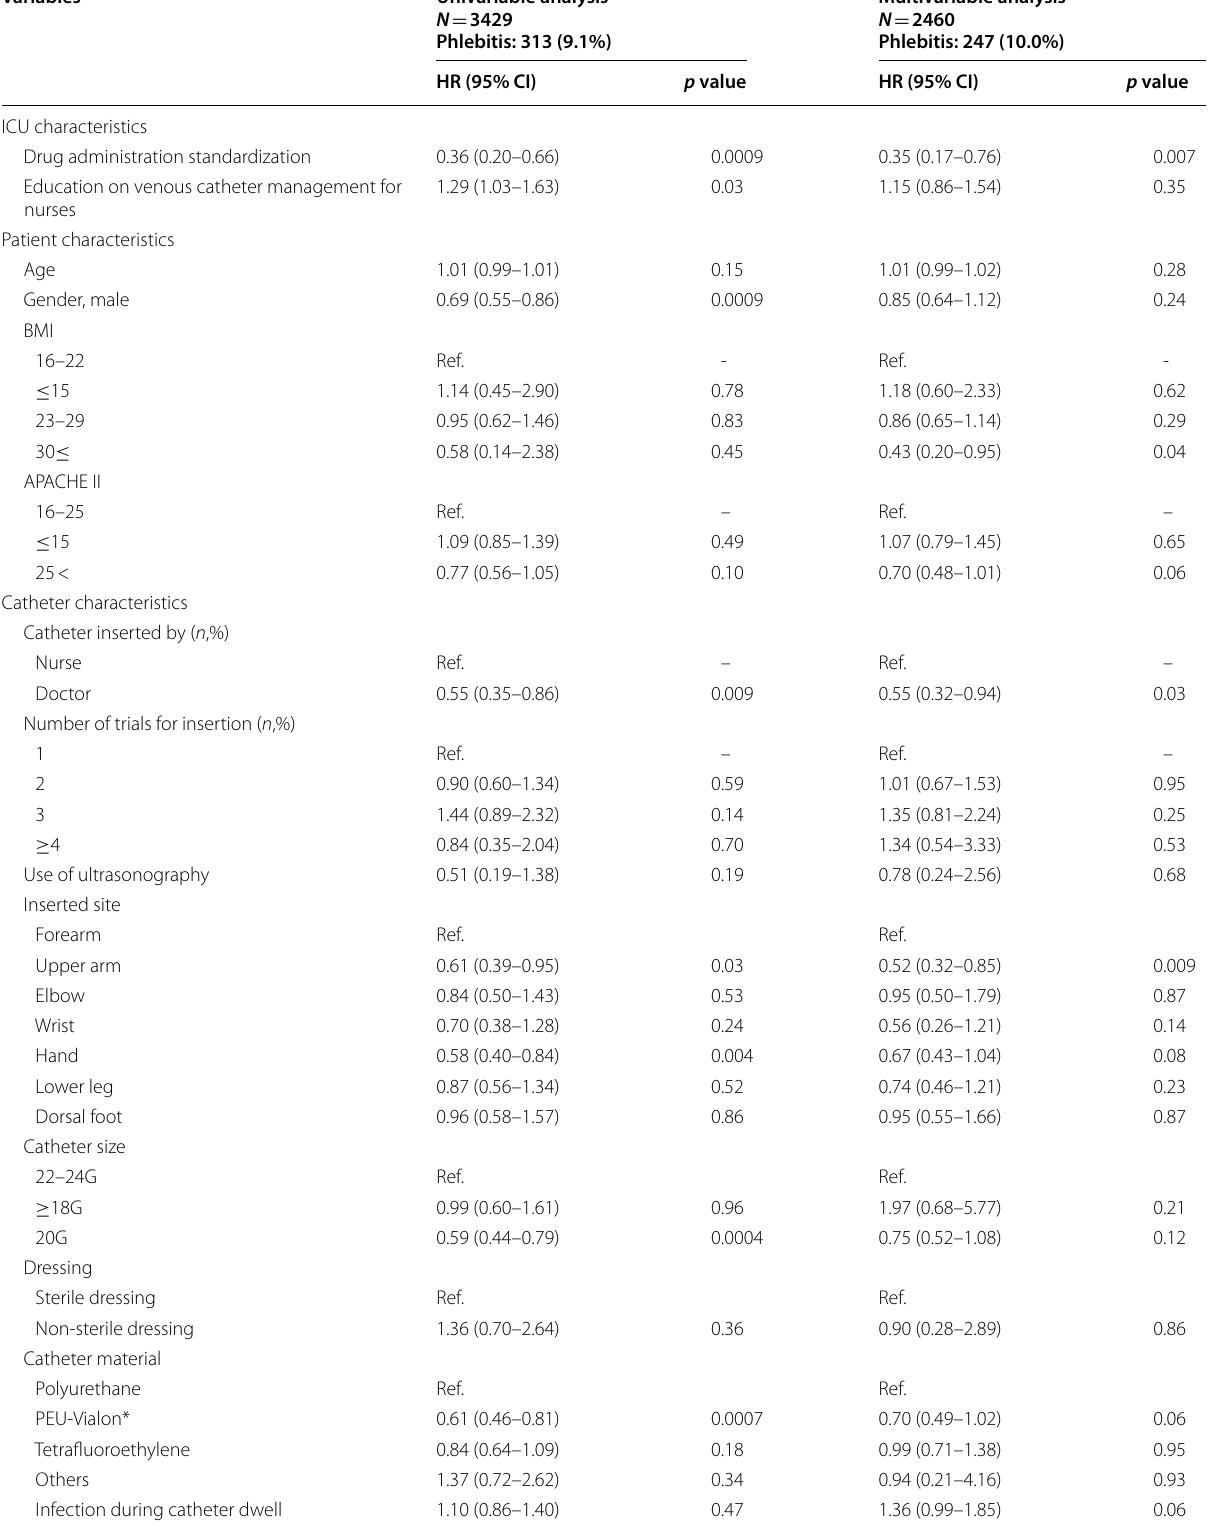
Table 4 Univariate and multivariable analysis for phlebitis using marginal Cox regression analysis for phlebitis